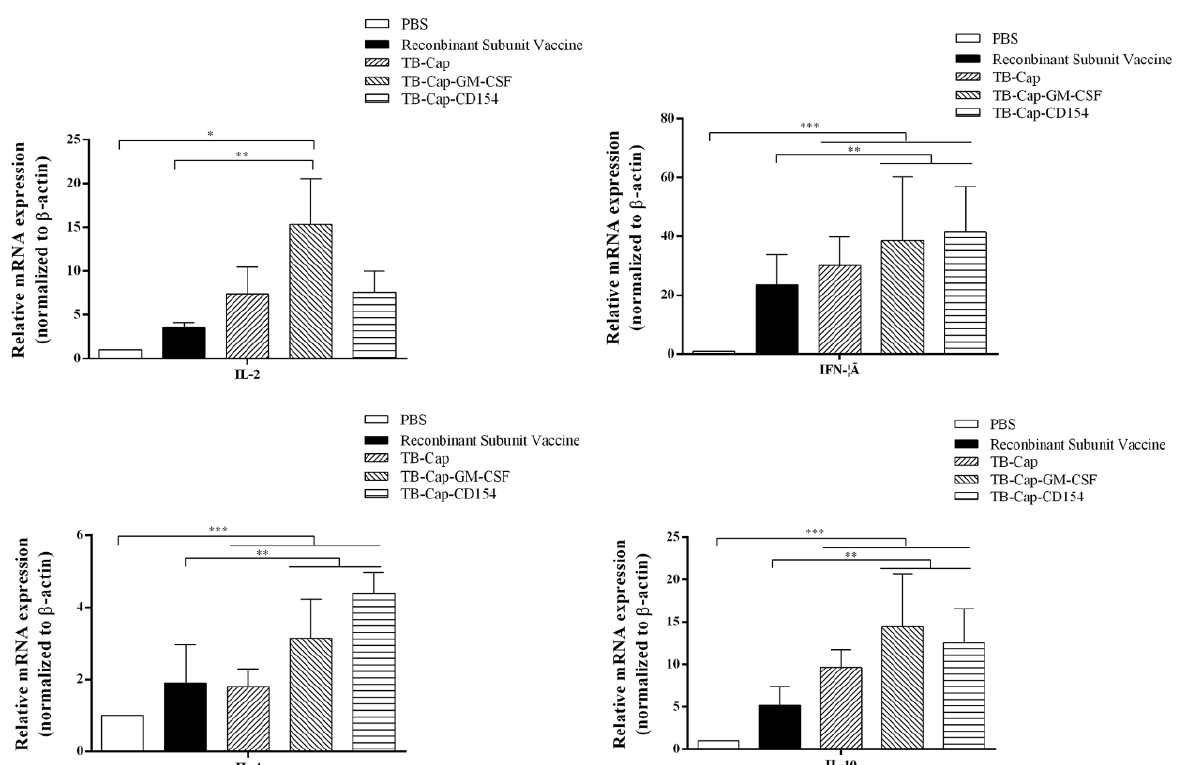
Figure 9. The levels of IL-2, IFN-gamma, IL-4 and IL-10 cytokine secretion. The mRNA levels of IL-2, IFN-gamma, IL-4 and IL-10 were analyzed by qRT-PCR in serum of mice on the day 28 after challenge. Data represent the mean ± SD. An asterisk (*) shows a statistically significant difference between the indicated groups ( p < 0.05). (*): p < 0.05; (**): p < 0.01; (***): p < 0.001; (****): p < 0.0001.